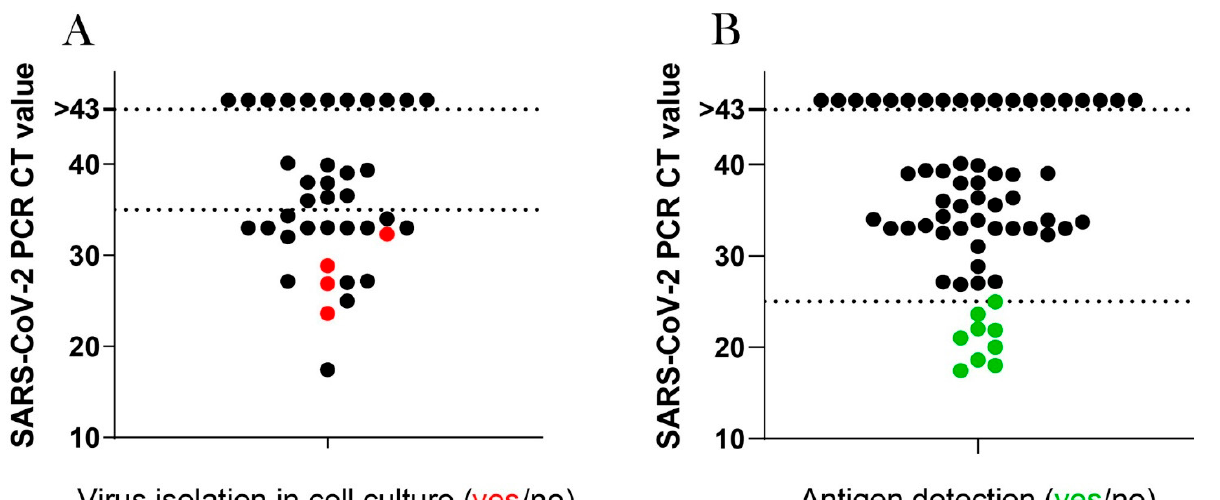
Figure 7. Correlation analyses for SARS-CoV-2 PCR ct-values and virus cultivation (A) or antigen detection (B). Nasopharyngeal swabs from 79 COVID-19 patients were tested for SARS-CoV-2 RNA via PCR. Additionally, 39 samples of patients with a positive SARS-CoV-2 PCR were inoculated on Vero E6 cells to detect infectious virus ( A ) and 64 samples were tested for SARS-CoV-2 N antigen ( B ). Red dots ( • ) in ( A ) indicate samples with cultivatable SARS-CoV-2 and green dots ( • ) in ( B ) indicate samples with positive SARS-CoV-2 antigen test.